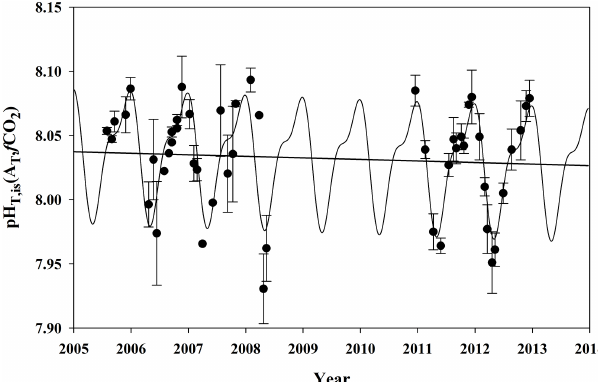
Figure 6. pH of surface waters in total proton scale and at in situ SST computed from total alkalinity (based on regional correlations with SST and SSS; Lee et al., 2006) and f CO 2 at 21 ± 0.25 ◦ N. The error bars represent the standard deviation of the computed data for each cruise for the selected latitude. The black curve shows the harmonic fitting of Eq. (4) for the data and the corresponding linear trend is also